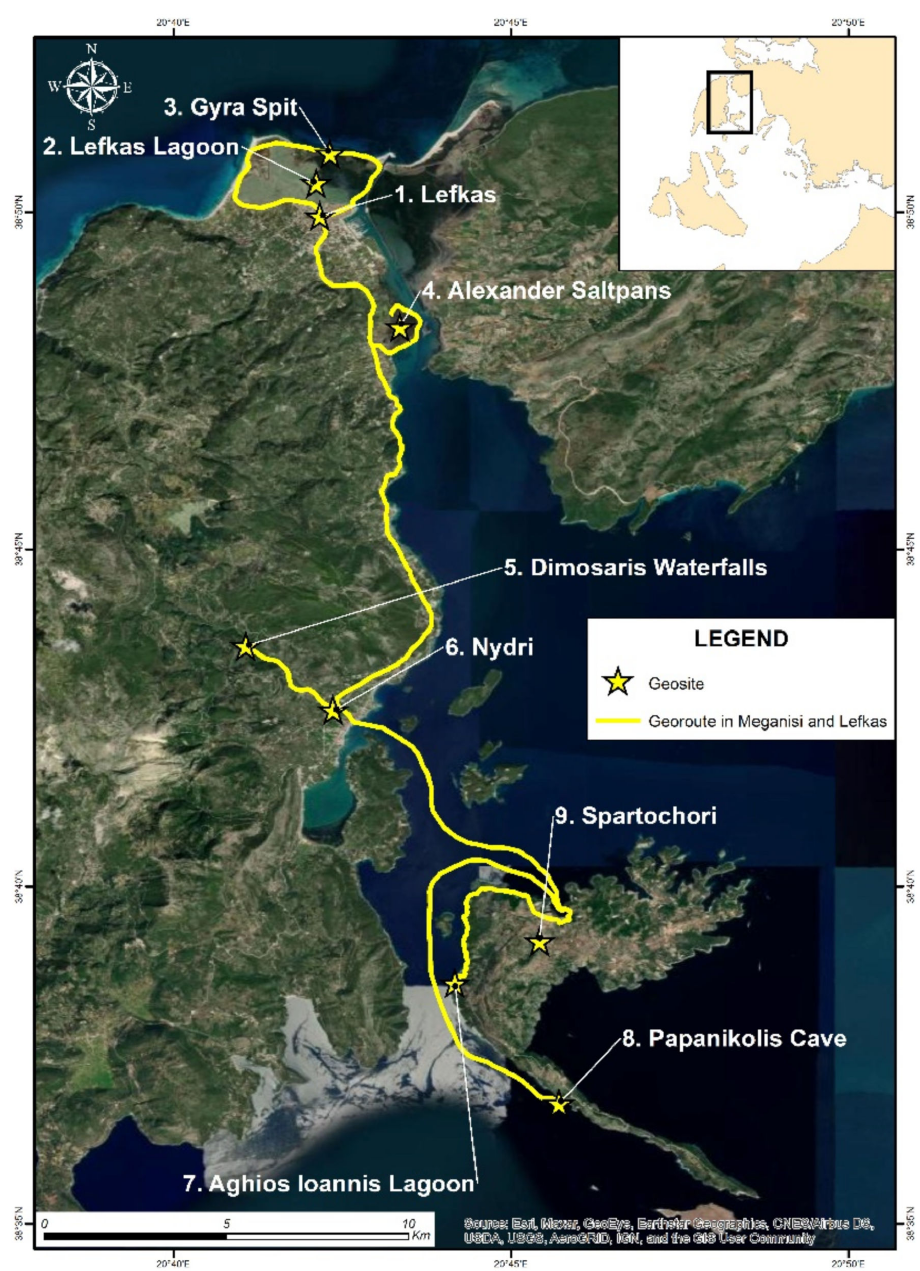
Figure 15. Lefkas and Meganisi inter-island